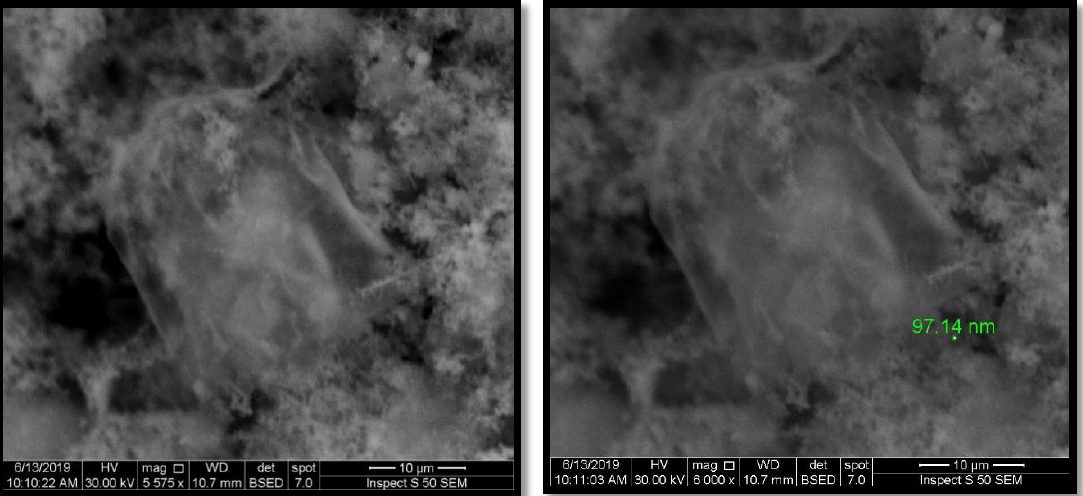
Fig.9: (c) SEM for PPy with 5%GN.